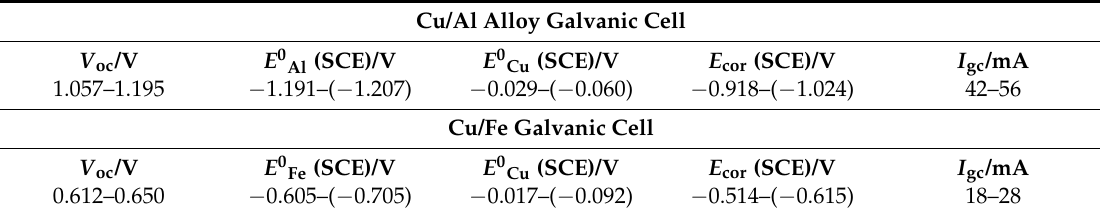
Table 1. Recorded ranges of electrical parameters (open-circuit voltage and electrode potential, mixed-corrosion potential and galvanic current-intensity) for Cu/Al alloy and Cu/Fe galvanic couples, obtained upon phenol and resorcinol electrodegradation